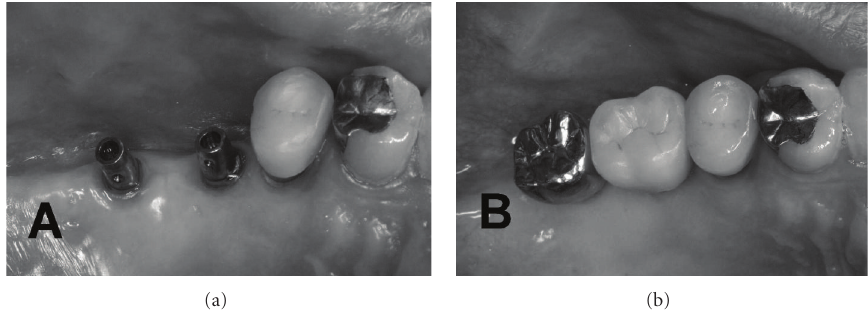
Figure 2: Although there is no evidence regarding the preferred restorative materials in implant prosthesis for the patients with bruxism, some clinicians applied non porcelain but metal restorations to protect the implant prostheses in patients with bruxism, especially for second molar teeth in the maxilla (since there is no esthetic problem).